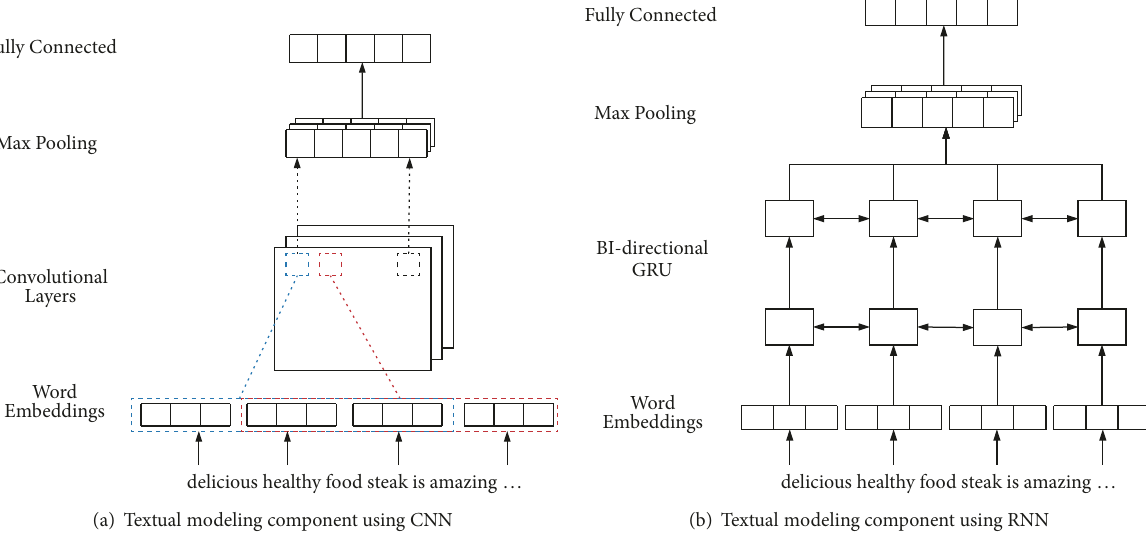
Figure 2: Proposed alternatives to learn user and location representations from textual reviews. 2(a) is a CNN-based solution employed in TCENR, while 2(b) illustrates the suggested extension using